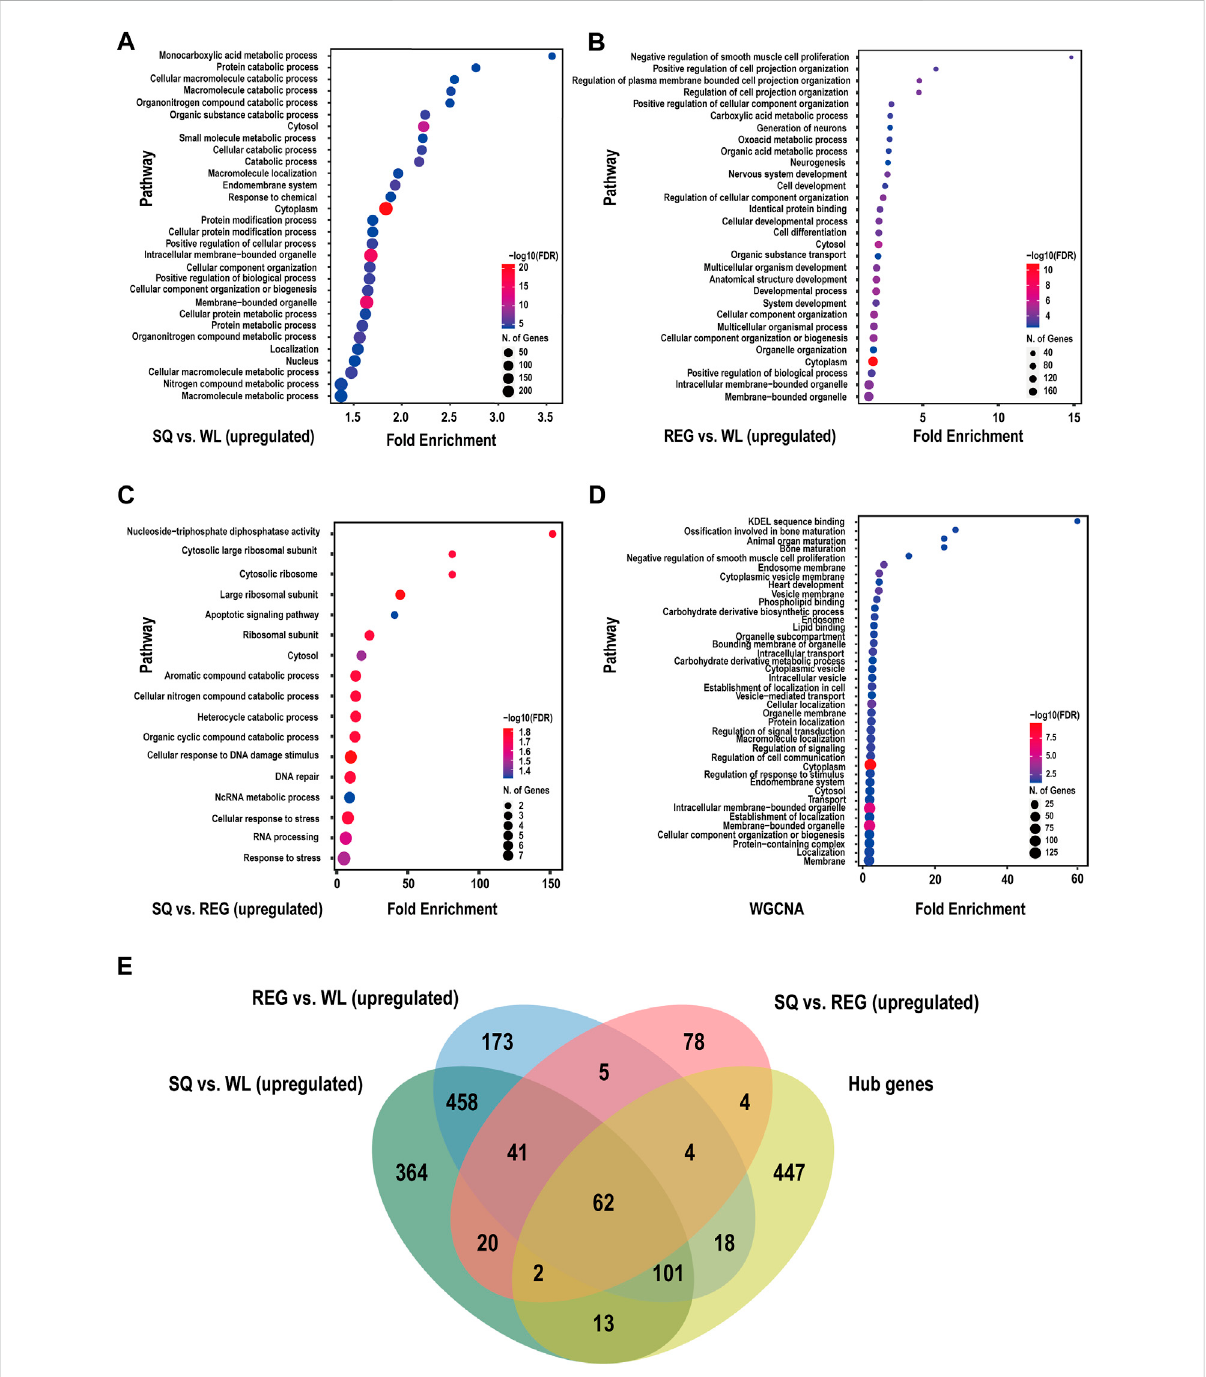
FIGURE 4 Functional enrichment analysis of DEGs (upregulated) and hub genes in plateau pika. (A) Functional analysis results of genes upregulated in SQ vs. WL. (B) Functional analysis results of genes upregulated in REG vs. WL. (C) Functional analysis results of genes upregulated in SQ vs. REG. (D) Functional analysis results of altitude-related hub genes screened by WGCNA. (E) Venn diagram presenting the results of interspeci fi c and intraspeci fi c variance analysis and